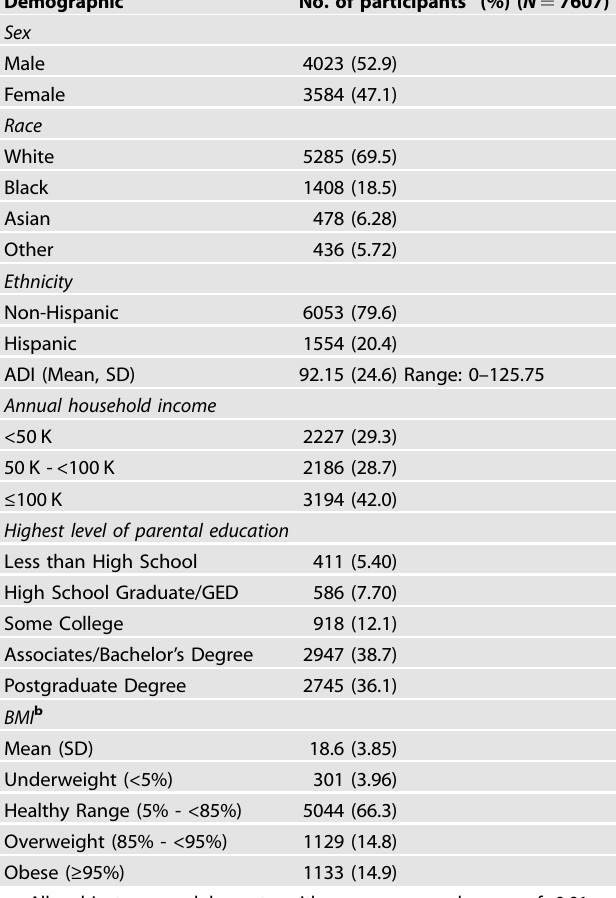
Table 1. Participant characteristics.